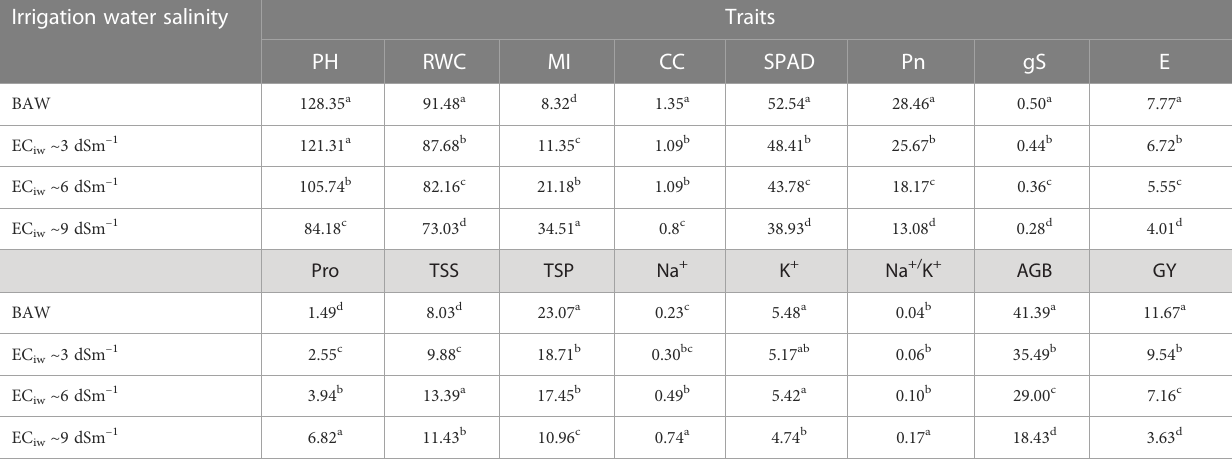
TABLE 3 Effect of salinity stress on morpho – physiological attributes of crop growth and yield in pearl millet (averaged across 7 hybrids and 10 inbred lines). Irrigation water